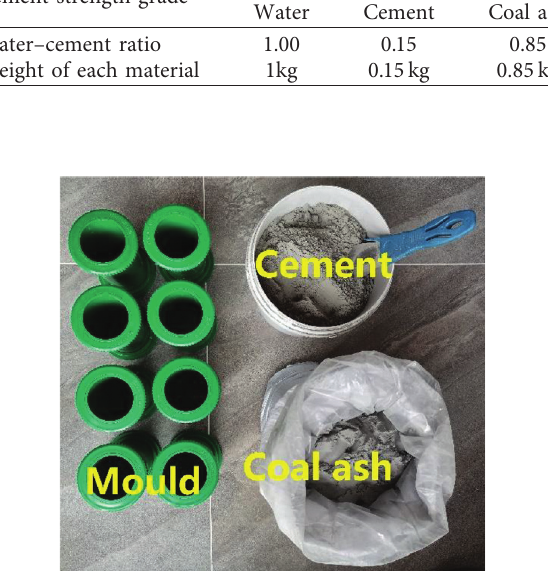
Figure 5: The cement, coal ash, and mould.